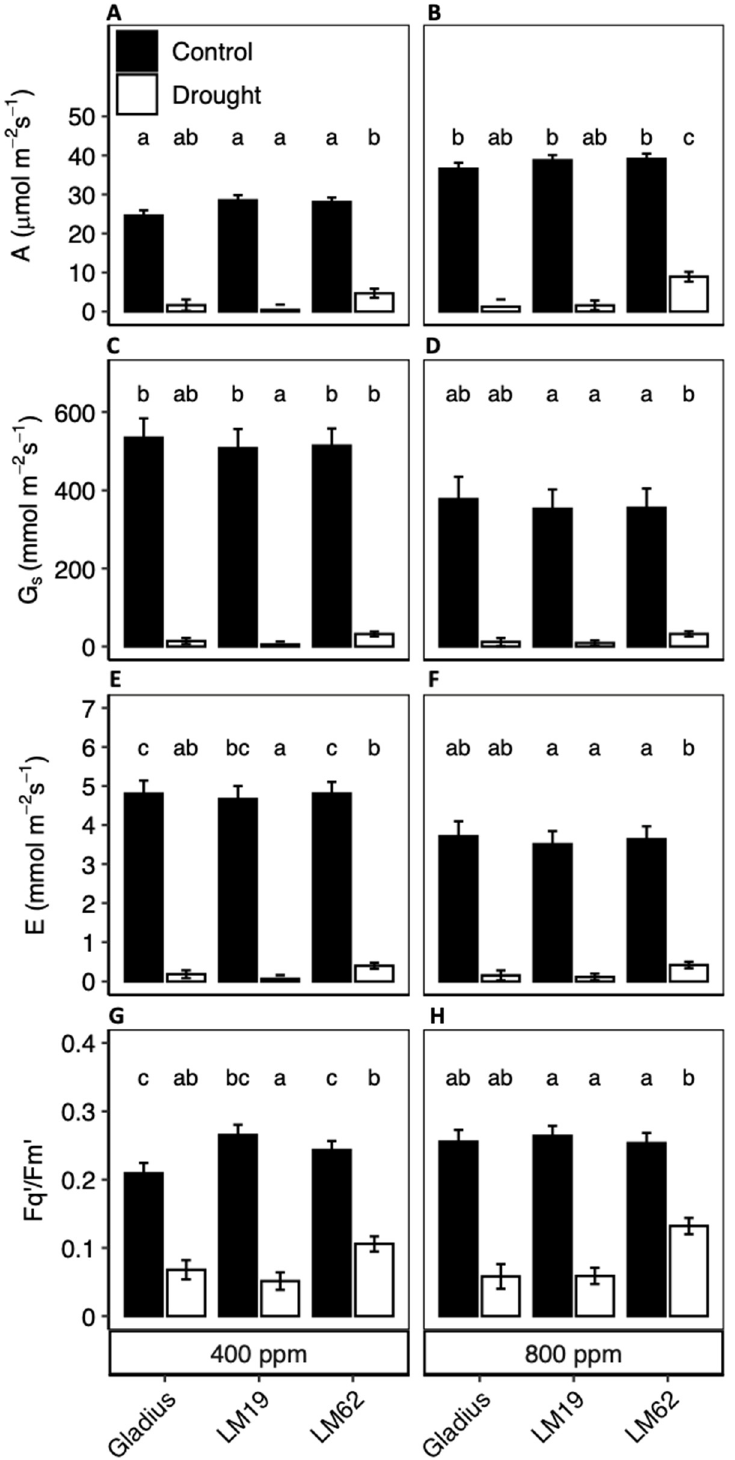
Figure 3. ( A , B ): Net photosynthetic assimilation (A), ( B , D ): Stomatal conductance (g s ), ( E , F ): Leaf transpiration rate (E) and ( G , H ): quantum yield of PSII (F q ’/F m ’) of three spring wheat genotypes (Gladius, LM19 and LM62) under well-watered conditions (Control, black bars) or affected by drought (Drought, white bars) at aCO 2 (400 ppm: ( A , C , E , G ) ) and eCO 2 (800 ppm: ( B , D , F , H )). The measurements were done at a PPFD of 1500 µmol m − 2 s − 1 at the end of the treatment period. Values are mean ± SE ( n = 4). Values that share a letter are not significantly different according to Tukey’s honestly significant test ( p < 0.05).